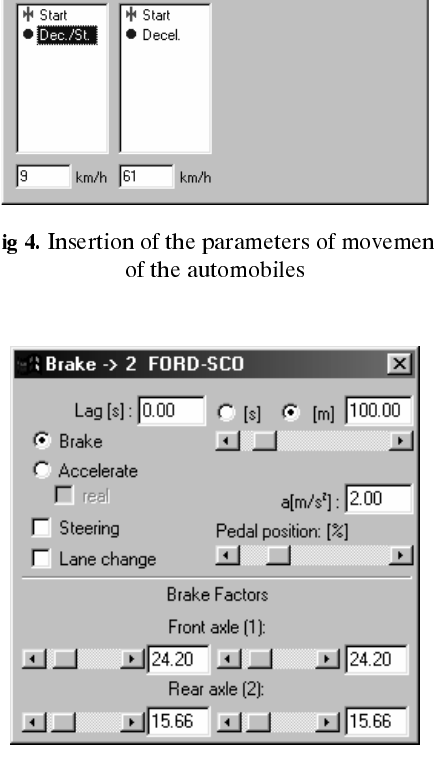
Fig 5. Insertion of the braking parameters of the automobile FORD SCORPIO